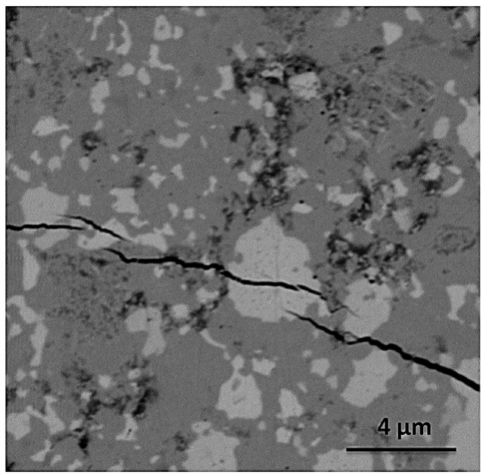
Figure 4. SEM image of crack microstructure details along the path of a crack produced by a Vickers